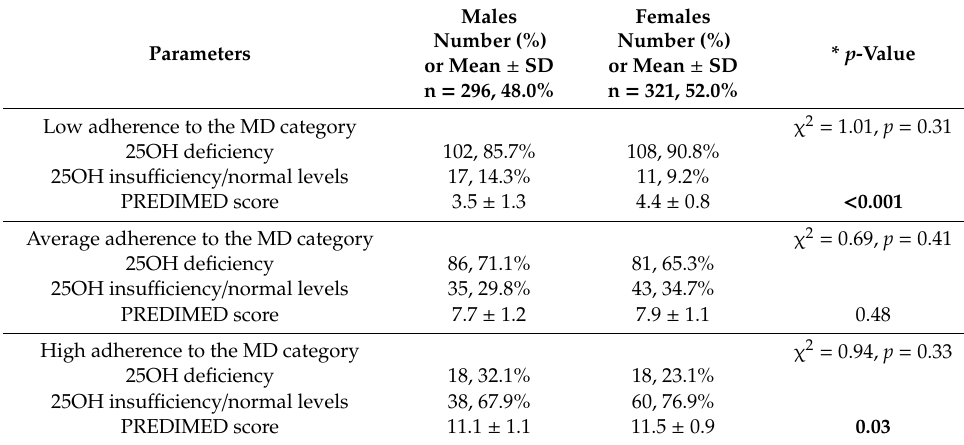
Table 4. Descriptive data of the 25OHD categories and PREDIMED scores according to PREDIMED categories and stratified by gender.